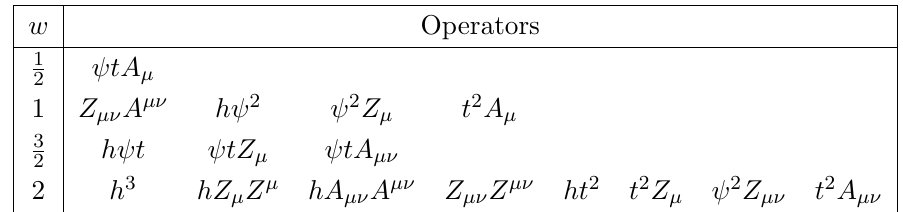
Table 2 . Table of operators in SMEFT containing at least one heavy field with weights w Operators are denoted by their field content, where Z µ and Z µν are the heavy Z (or W ) field and field-strength tensor, respectively; A µ and A µν are the light photon (or gluon) field and field- strength tensor, respectively; ψ is a light fermion; t is the heavy top quark and h is the heavy Higgs